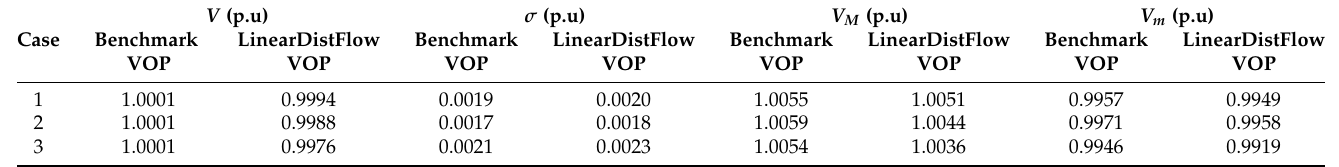
Table 3. Statistical parameters of the distribution of the nodal voltage